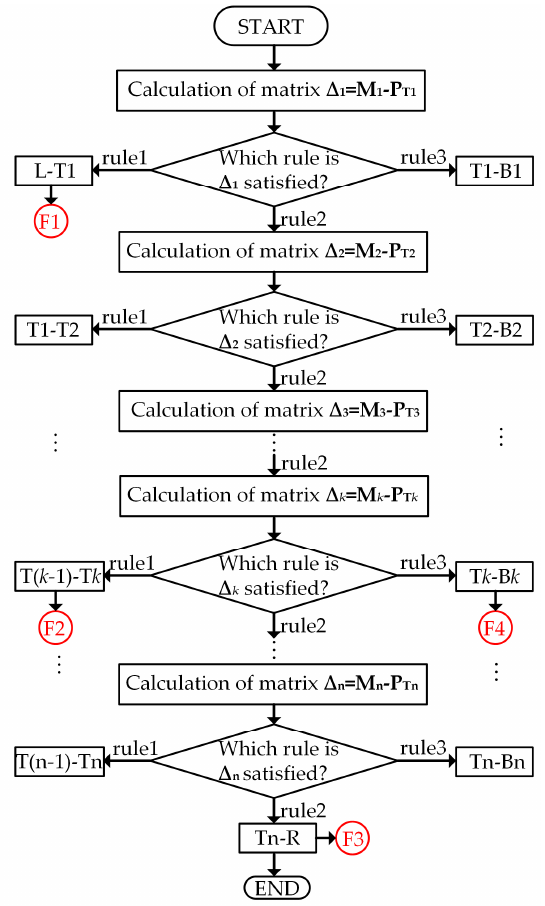
Figure 6. Flowchart of the proposed fault section identification method for multi-terminal transmission line.